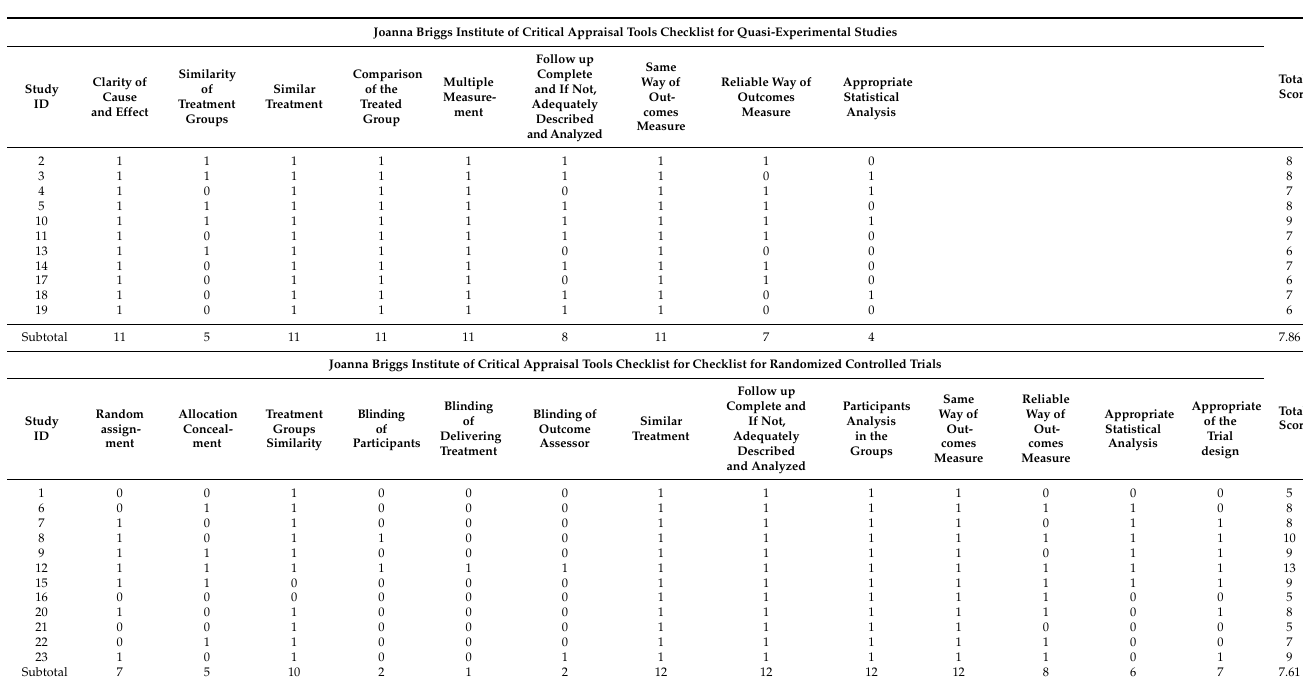
Table 3. Quality assessment of the included studies. JoannaBriggsInstituteofCriticalAppraisalToolsChecklistforQuasi-ExperimentalStudies